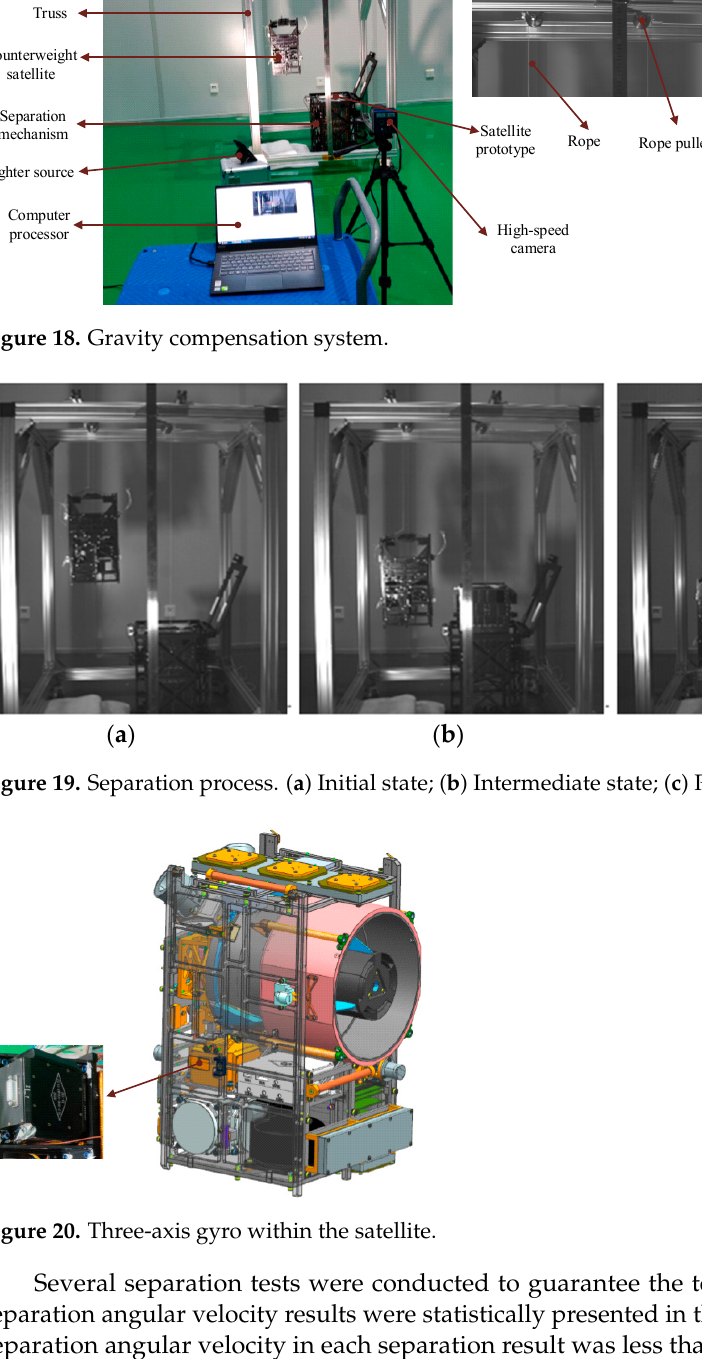
Figure 18. Gravity compensation system.